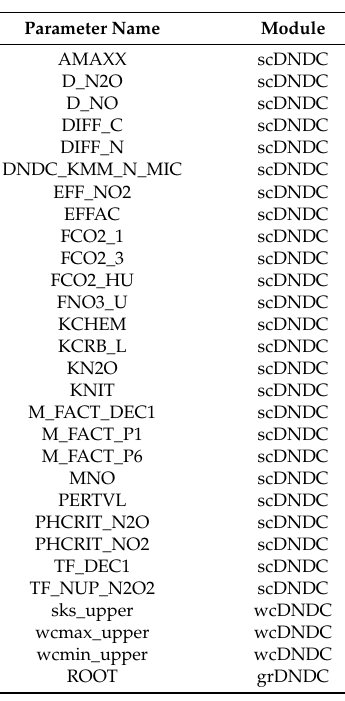
Table A2. Most sensitive LandscapeDNDC parameters. From left: internal LandscapeDNDC parameter name, parameters associated module, if the parameter was found sensitive for noGW/withGW, the lower and upper limits of the parameter range, process-related